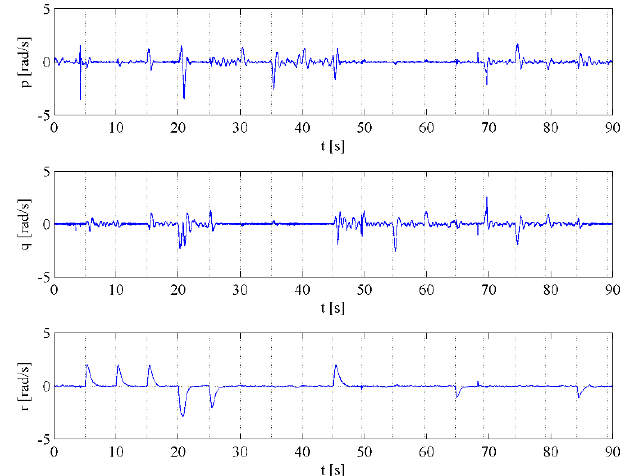
Figure 18. Angular velocity in E B (the body-fixed frame) of the quadrotor when using backstepping controller.